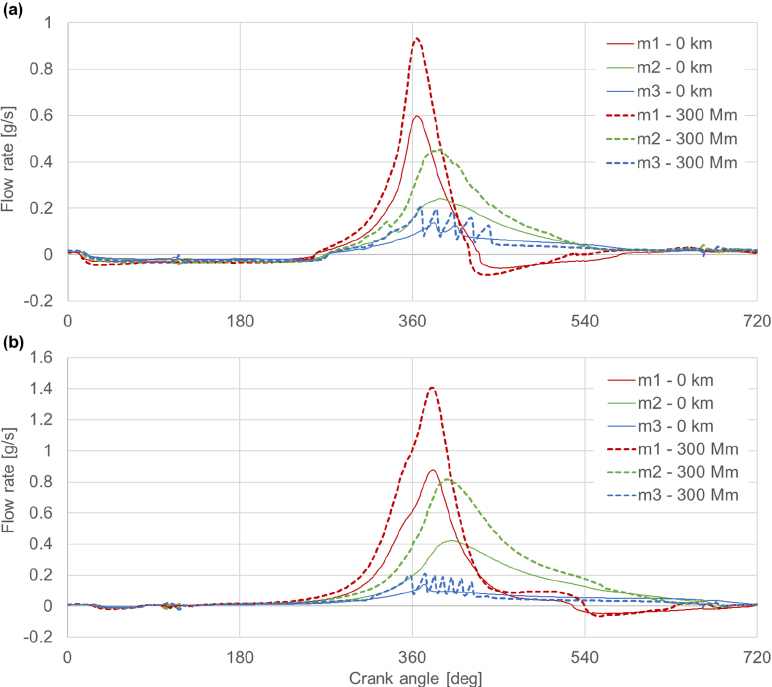
Figure 9. Mass flow rates in the ring end gaps for different wear and loads: ( a ) engine load 20 Nm; ( b ) engine load 168 Nm.